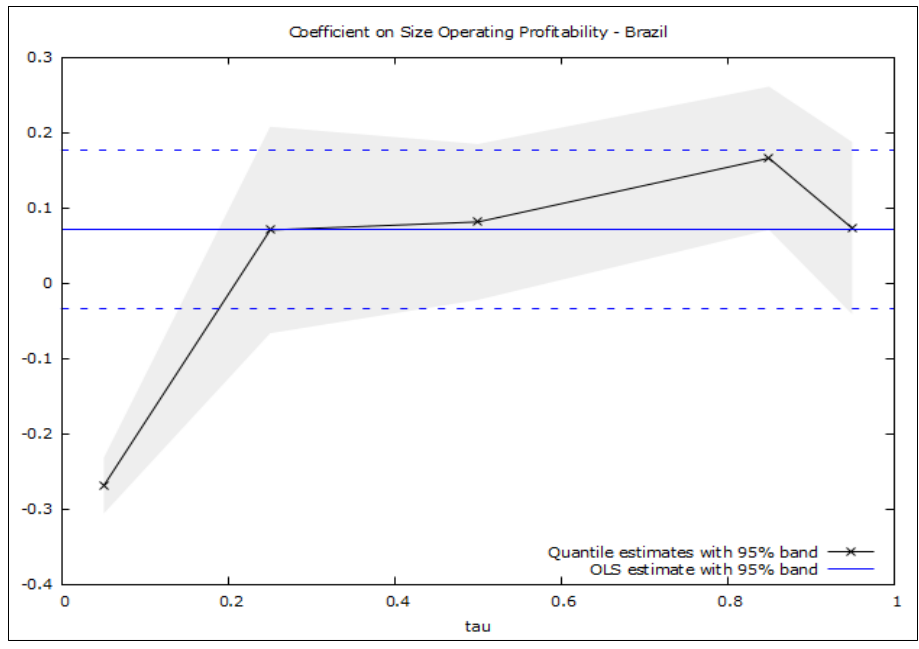
Figure A3. Performance of the SMB OP risk factor on the percentiles and conditional average of Brazil’s GDP growth rate.